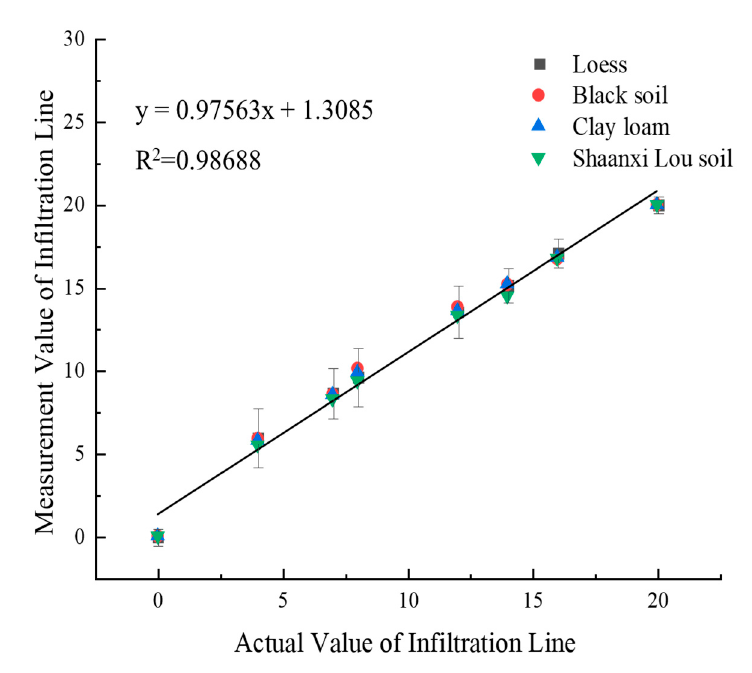
Figure 7. Correlation verification of multi-layer soil infiltration line.